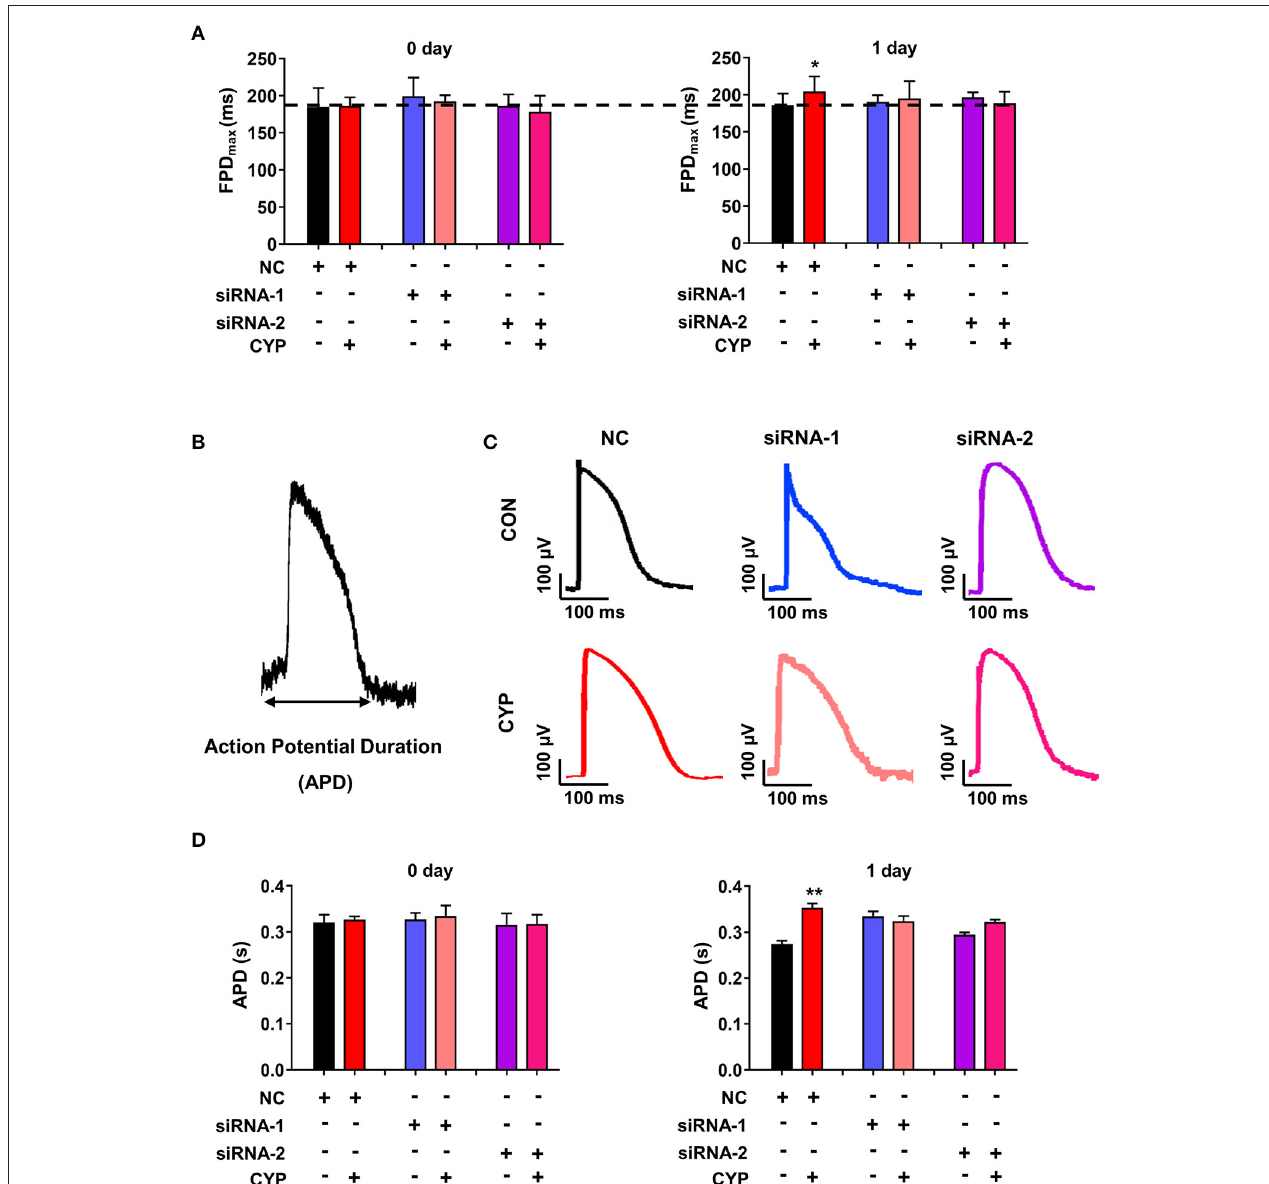
FIGURE 7 | Disruption of METTL3 expression eliminated the increased field potential duration (FPD) and action potential duration (APD) induced by CYP in cardiomyocytes. (A) Silencing METTL3 expression eliminated the increase in FPD induced by CYP. (B) Schematic of APD by the MEA processing of cardiomyocytes. (C) Representative images of APD in NRCMs transfected with si-METTL3, or negative control (NC) sequences with/without CYP. (D) Quantification of APD in NRCMs transfected with si-METTL3 or NC sequences with/without CYP. Silencing METTL3 expression eliminated the increased APD induced by CYP. The data are shown as the mean ± SE of three experiments. * P < 0.05; ** P < 0.05 vs.